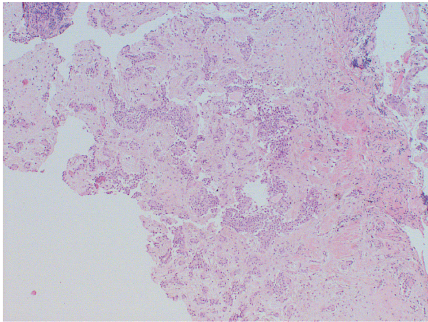
Figure 2: Biopsy fragment characterized by the mixture of ele- ments myoepithelial and stromal areas of mixocondoide appearance (hematoxylin-eosin 40x).